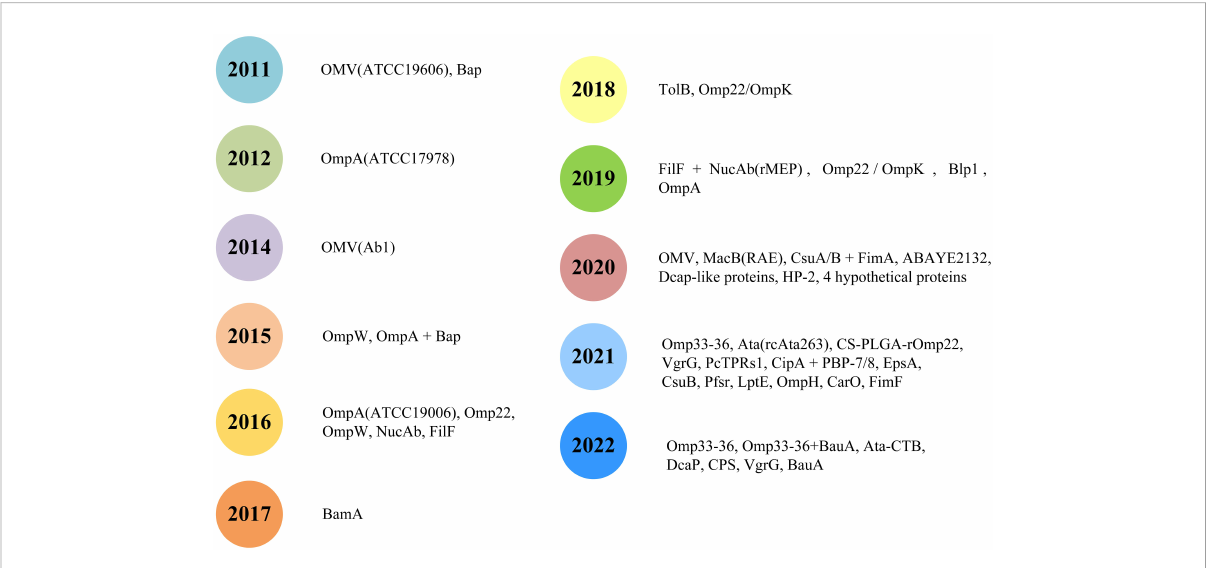
FIGURE 2 Subunit vaccines for Acinetobacter baumanni